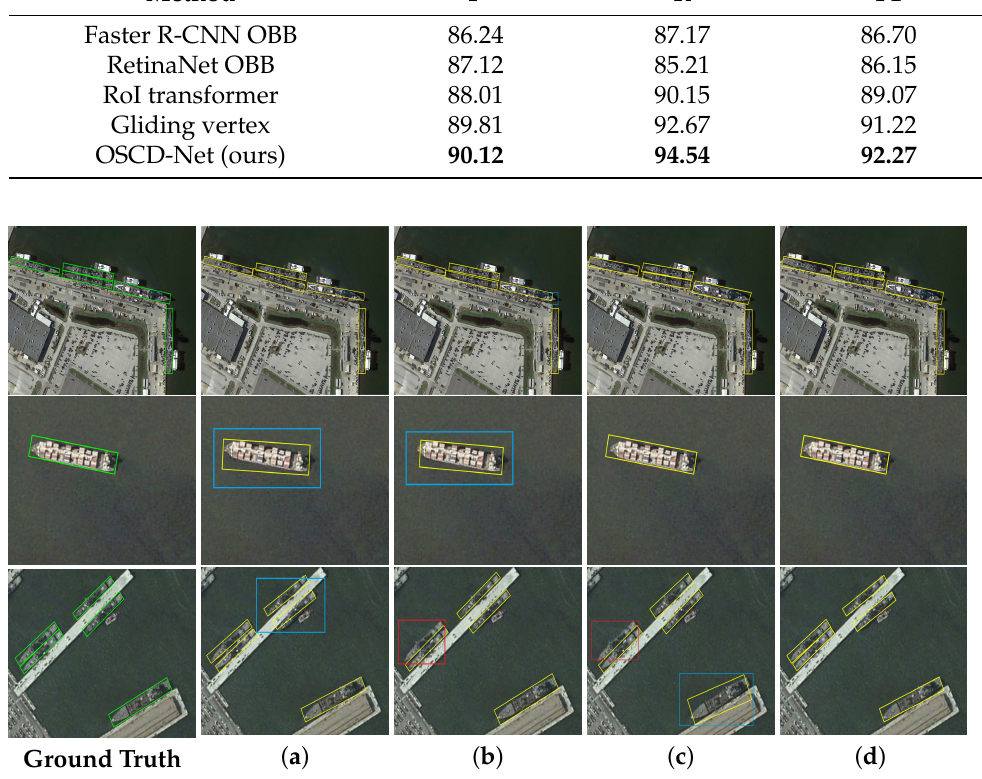
Figure 11. Comparison experiment detection results on HRSC2016 dataset. The green box in the first column represents the ground truth. The yellow box indicates the detection result. The red box indicates the missed detection area, and the blue box indicates the inaccurate detection area. ( a ) The detection result of Faster R-CNN. ( b ) The detection result of RoI transformer. ( c ) The detection result of Gliding vertex. ( d ) The detection result of